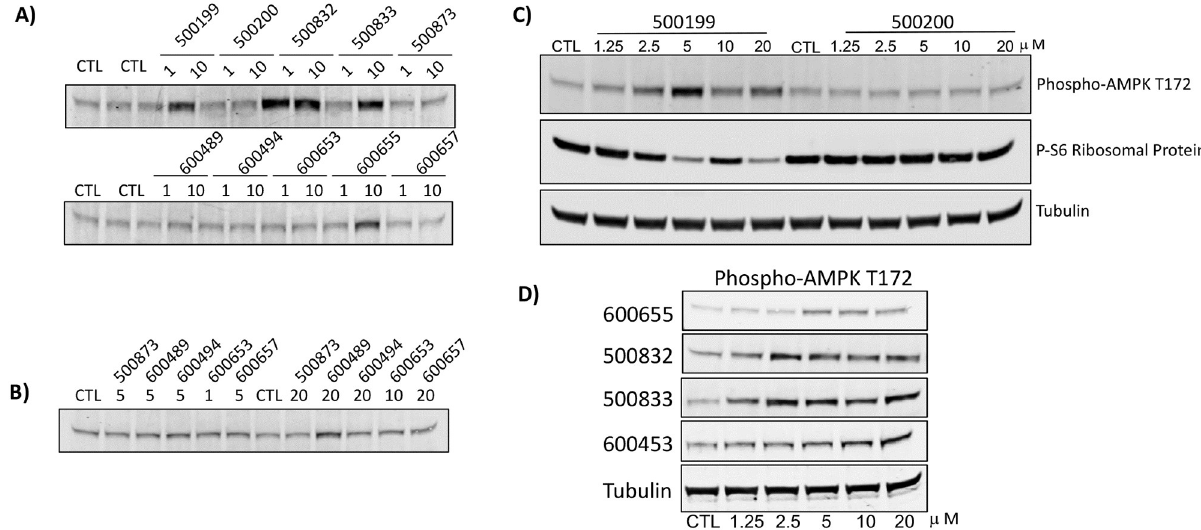
Fig 4. Validation of AMPK pathway activation by phenylbenzamide derivatives in HepG2 cells. A) Cells were seeded at 10,000 cells per well 24 hours prior to treating cells with indicated concentration of compound or DMSO (CTL) for 4 hours. 16 μ L of cell lysate was incubated with HTRF phospho-AMPK detection reagents and fluorescence emission read at 665nm and 620nm using a PHERAstar platereader. The mean and standard deviation of the HTRF Ratio from three replicate wells is shown. The unstimulated (DMSO) and positive controls lysates are shown in green and red